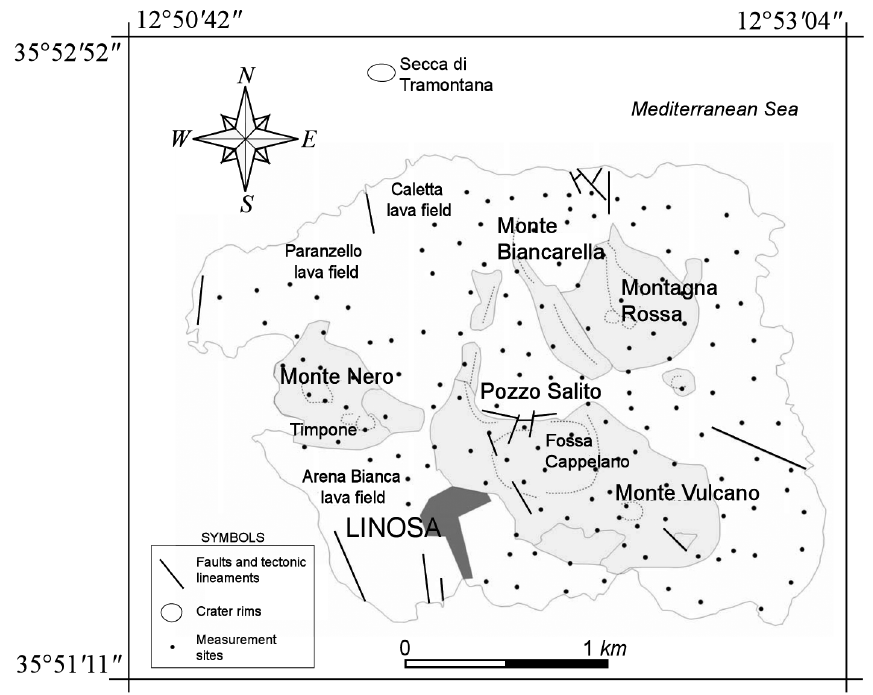
Figure 2. Simplified representation of the island of Linosa with the main tectonic lineaments (black lines) and volcanic centers (grey areas and dotted lines) (modified after Lanzafame et al. [1994]). Black points indicate the location of measurements for the soil CO